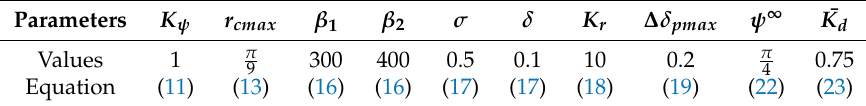
Table 4. The lateral-directional control law